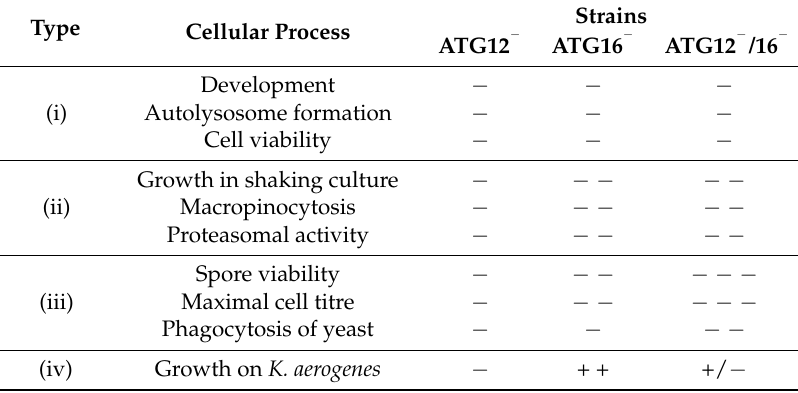
Supplementary Materials: The following supplementary information is available online. Figure S1: Generation and verification of the atg12 gene replacement mutant in AX2 and ATG16 − cells, Figure S2: Spore viability was significantly reduced in ATG12 − , ATG16 − and ATG12 − /16 − cells, Figure S3: Western blot analysis of AX2 and mutant strains expressing RFP-GFP-ATG8a, Figure S4: Growth of AX2, ATG12 − , ATG16 − and ATG12 − /16 − cells on a lawn of K. aerogenes , Figure S5: Western blot analysis of global protein ubiquitination and proteasomal subunit psmA7 (SU7) expression in AX2 and mutant strains, Table S1: List of transcriptional regulation of proteasomal genes, Table S2: List of differentially regulated autophagosomal genes in vegetative cells, Table S3: Gene ontology (GO) term enrichment analysis of differentially regulated genes in ATG12 − , ATG16 − and ATG12 − /16 −